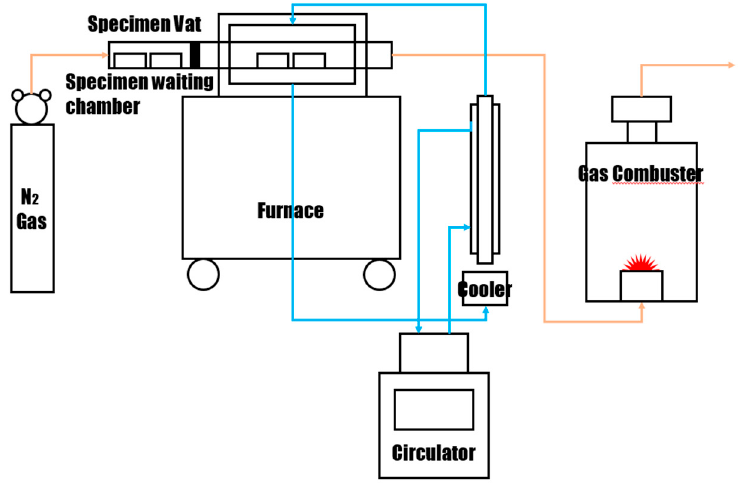
Figure 1. The schematic diagram of the pyrolysis apparatus.